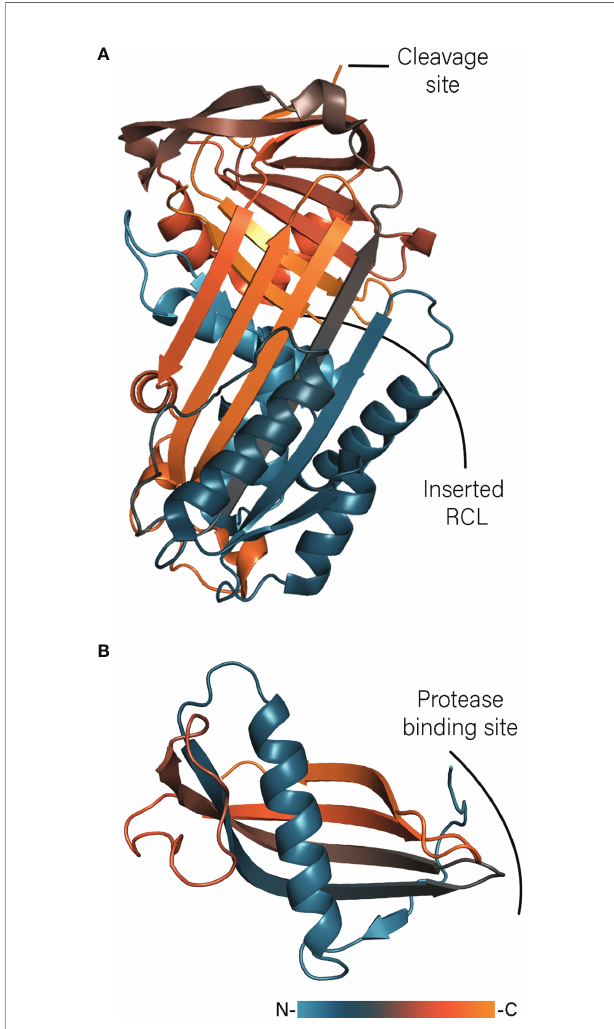
FIGURE 2 | Tick serpin Iripin-3 ( A , PDB: 7AHP) and cystatin Sialostatin L2 ( B , PDB: 3LH4) structures colored according to a gradient from N - to C